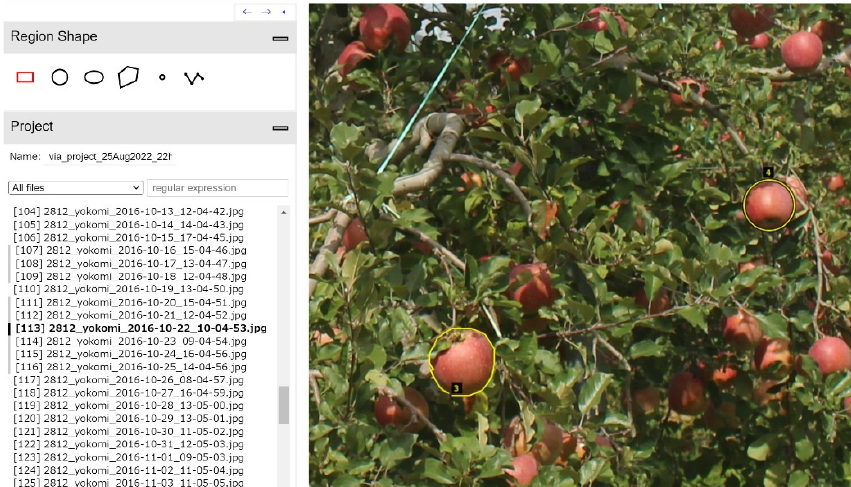
Figure 7. Example of annotation using VIA. Annotation of the regions was performed manually using the VGG Image Annotator, which could output the fruit contour in JSON format by enclosing the fruit region in the image.